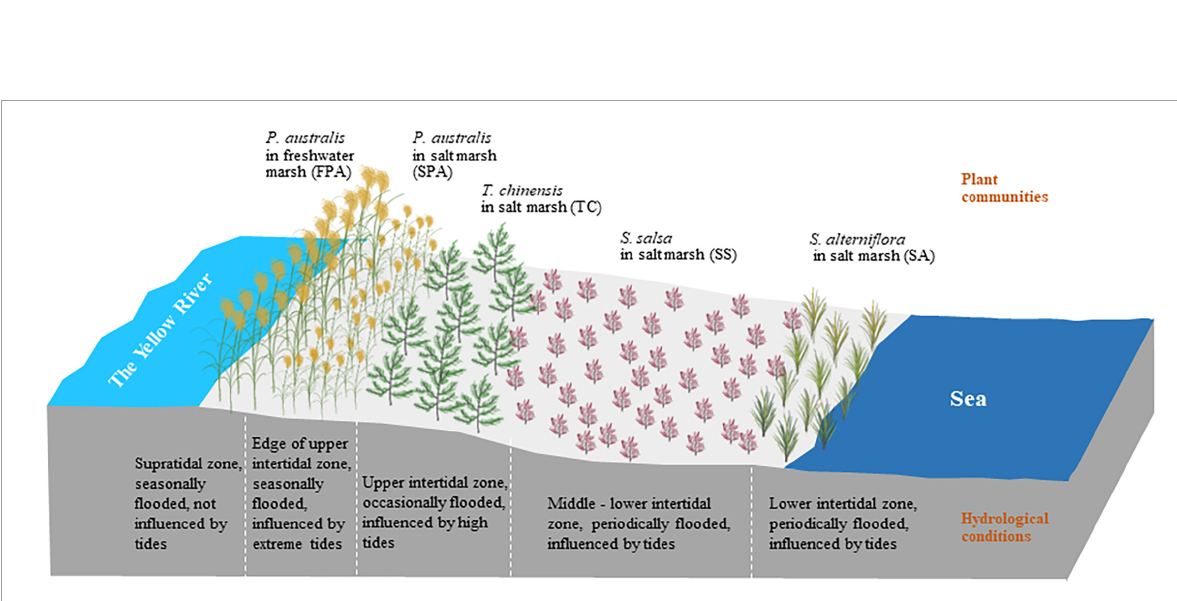
FIGURE2 Schematic diagram of the hydrological conditions for different plant